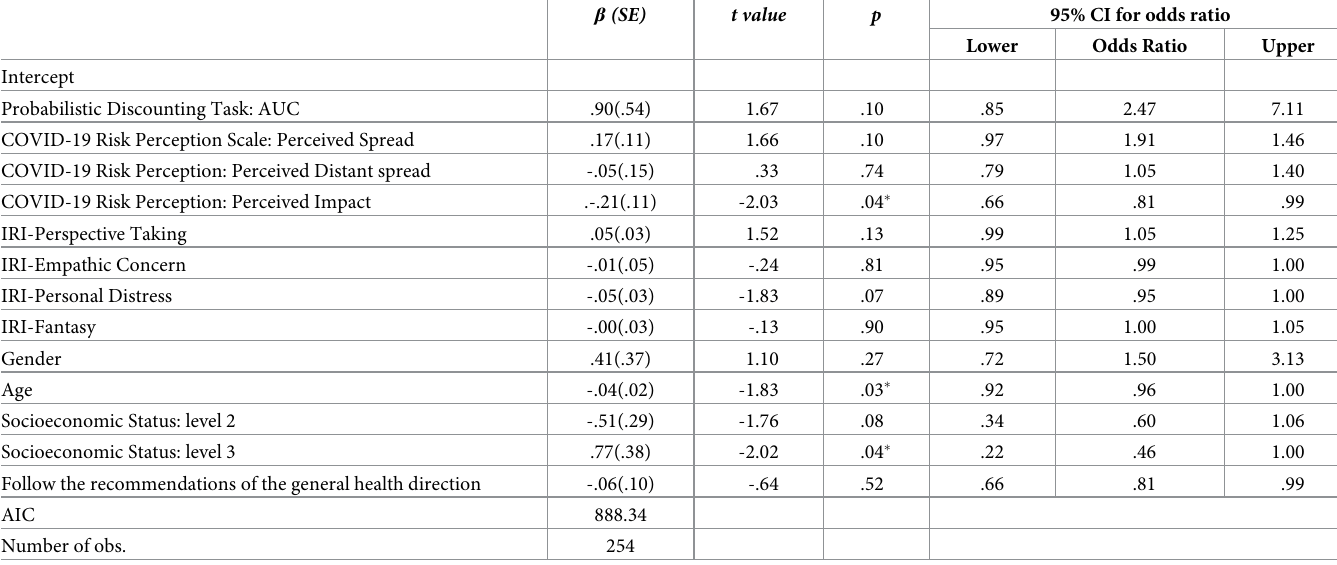
Table 2. Estimates of the ordinal logistic regression model for the individual